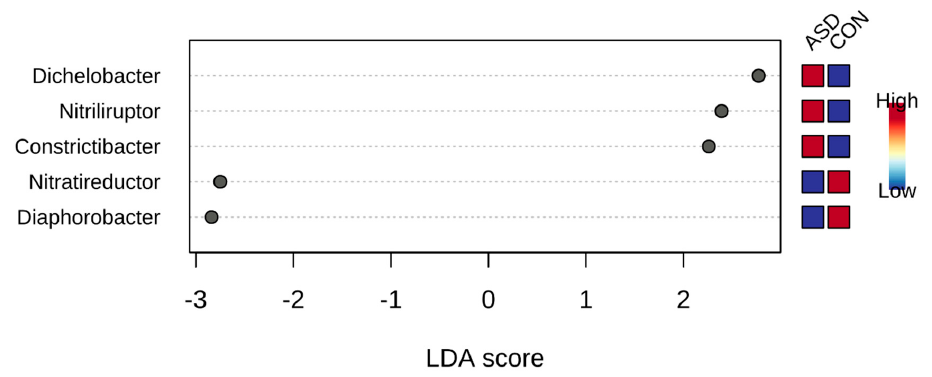
Figure 2. Microbiota biomarkers for ASD children compared to neurotypical, calculated with linear discriminant analysis effect size (LEfSe), MicrobiomeAnalyst.